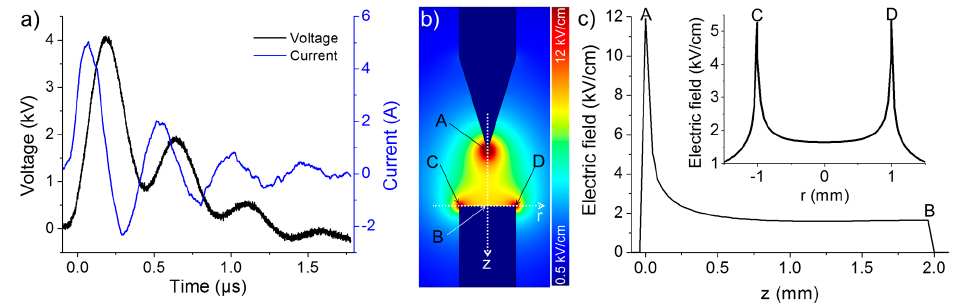
Figure 2. ( a ) Typical voltage-current characteristics for an applied voltage of 4 kV at σ 0 = 2 µS/cm. ( b ) 2D-simulation of the electric field distribution. ( c ) Axial and radial profiles of electric field intensity along the electrode axis and the cathode surface derived from the simulation shown in ( b ).